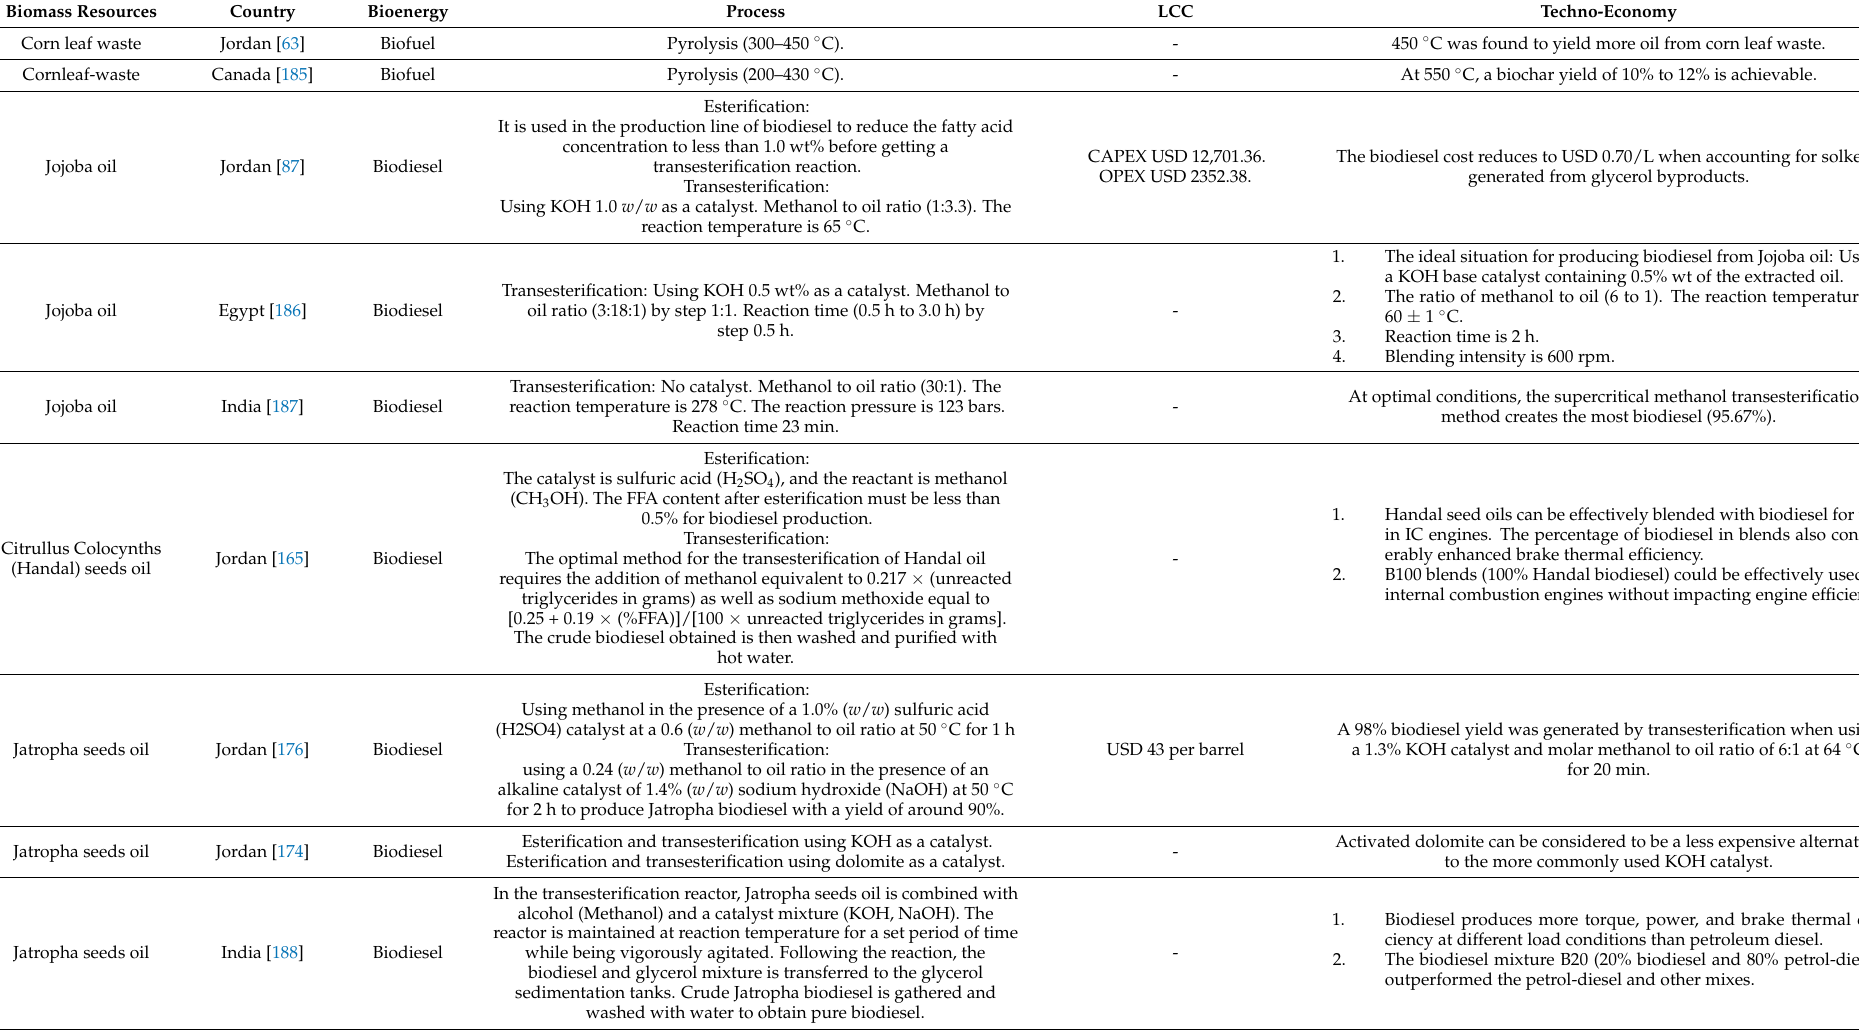
Table 14. Jordan’s bioenergy in comparisons with global